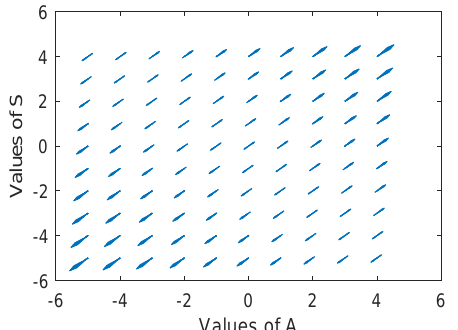
Figure 7. Phase portrait for differential Equation